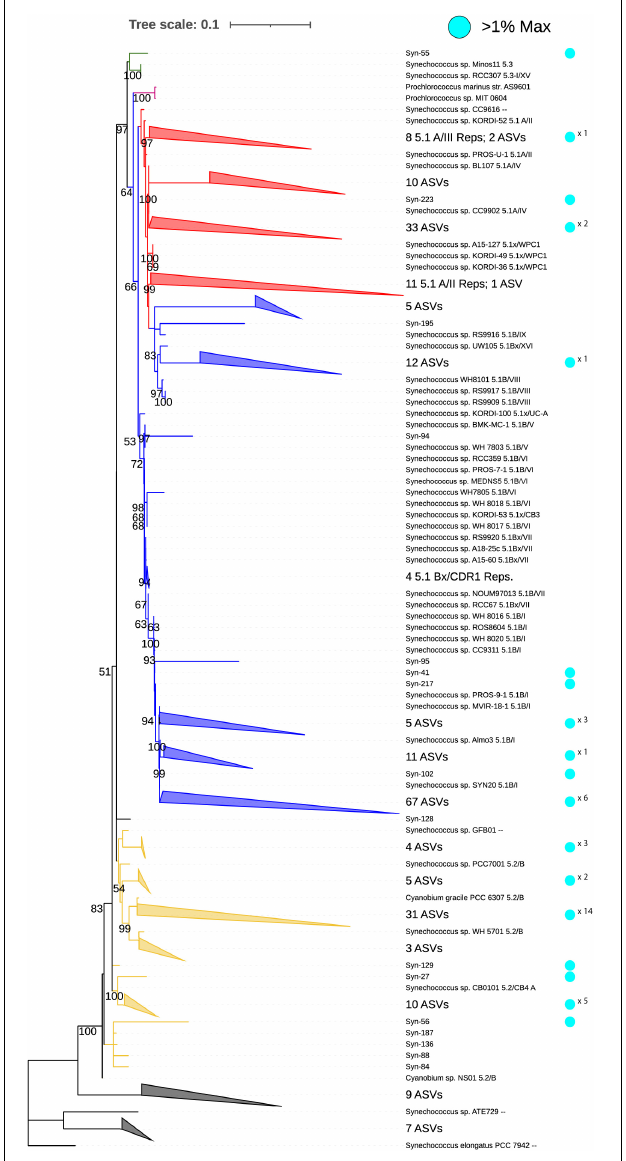
FIGURE 4 | Phylogenetic tree showing 231 environmental Synechococcales (Syn) 16S rRNA gene ASVs (V3–V4 subunit) placed within the full 16S reference phylogeny of 72 Synechococcus strains representing subclusters 5.1, 5.2, 5.3 and freshwater isolates as well as Prochlorococcus (violet). Branch colors indicate the subcluster classification for 5.2 (yellow), 5.3 (green), 5.1A (red), 5.1B (blue). Black branches indicate freshwater strains. Cyan circles indicate ASVs that composed > 1% of the data in an individual sample library. For collapsed branches, cyan circles with × n indicate the number of ASVs within that meet the criteria. Bootstrap values (1,000 replicates) are shown for a range of 0–100, only showing values > 50.